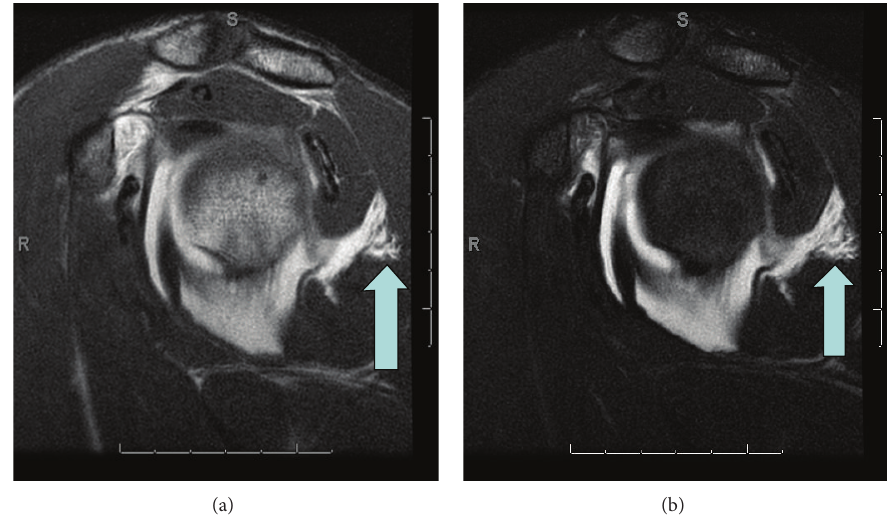
Figure 2: Case 6. Oblique sagittal T1 and T2 demonstrate contrast/fluid extravasating between muscle fibers of teres minor